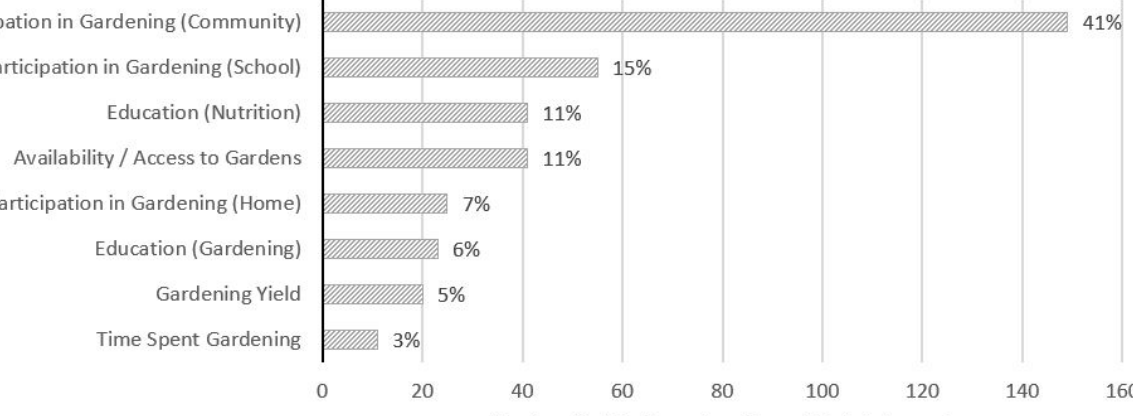
Figure 4. Studies by their primary thematic focus ( n = 272).